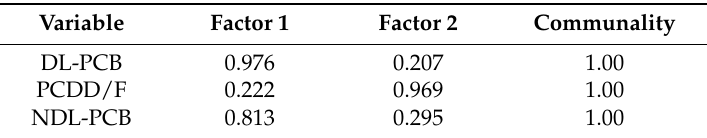
Table 3. Rotated factor loadings and communalities after Varimax rotation. Variable